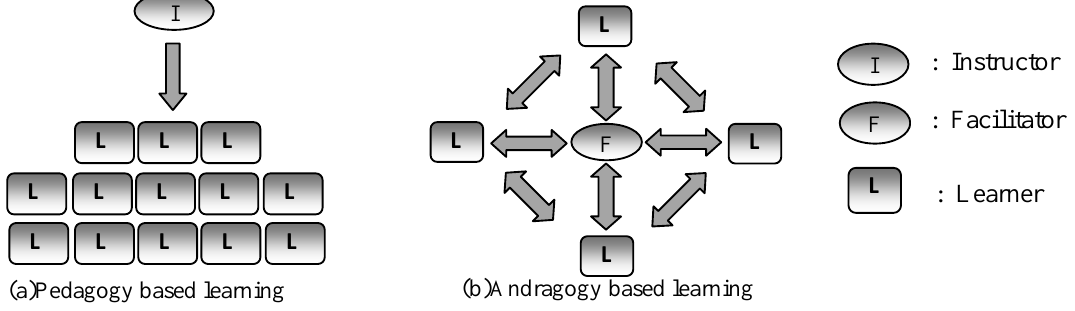
Figure 2 Schematic representation of two major theories of